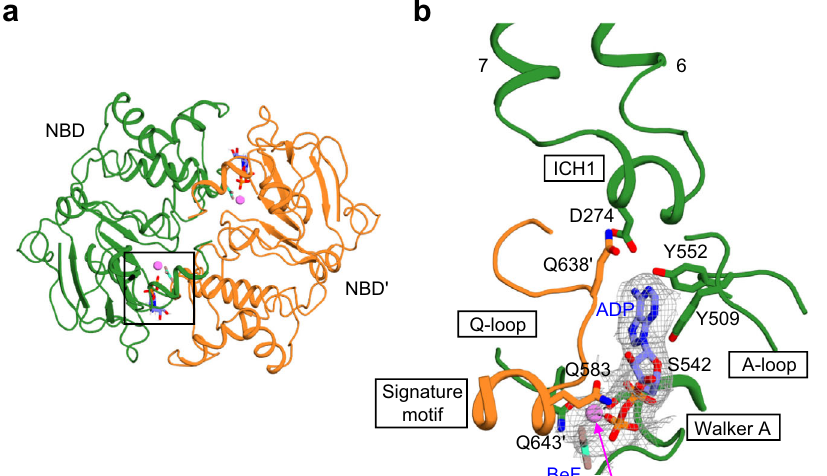
Fig. 8 | The nucleotide-binding site. a The NBD dimer is viewed from the cyto- plasm.BoundMg 2+ andADP·BeF 3 arerepresentedbysphereandstick,respectively. Theareaenlargedin( b )isboxed. b Close-upviewoftheADP·BeF 3 bindingsite.The